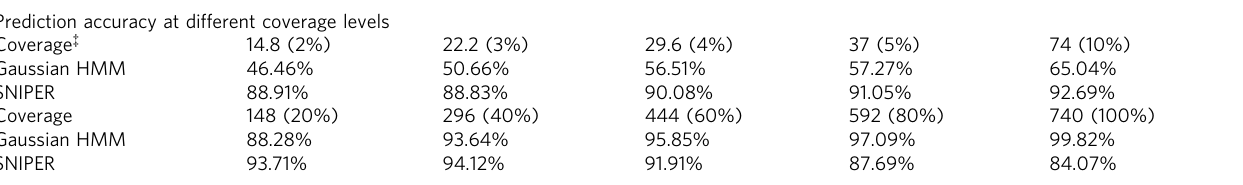
Table 2 Subcompartment prediction accuracy of the Gaussian HMM and SNIPER at various levels of coverage. SNIPER outperforms the Gaussian HMM when the inter-chromosomal matrix is below 60% of the original GM12878 inter-chromosomal read count and the performance is dramatically better at lower coverage levels Prediction accuracy at different coverage levels Coverage